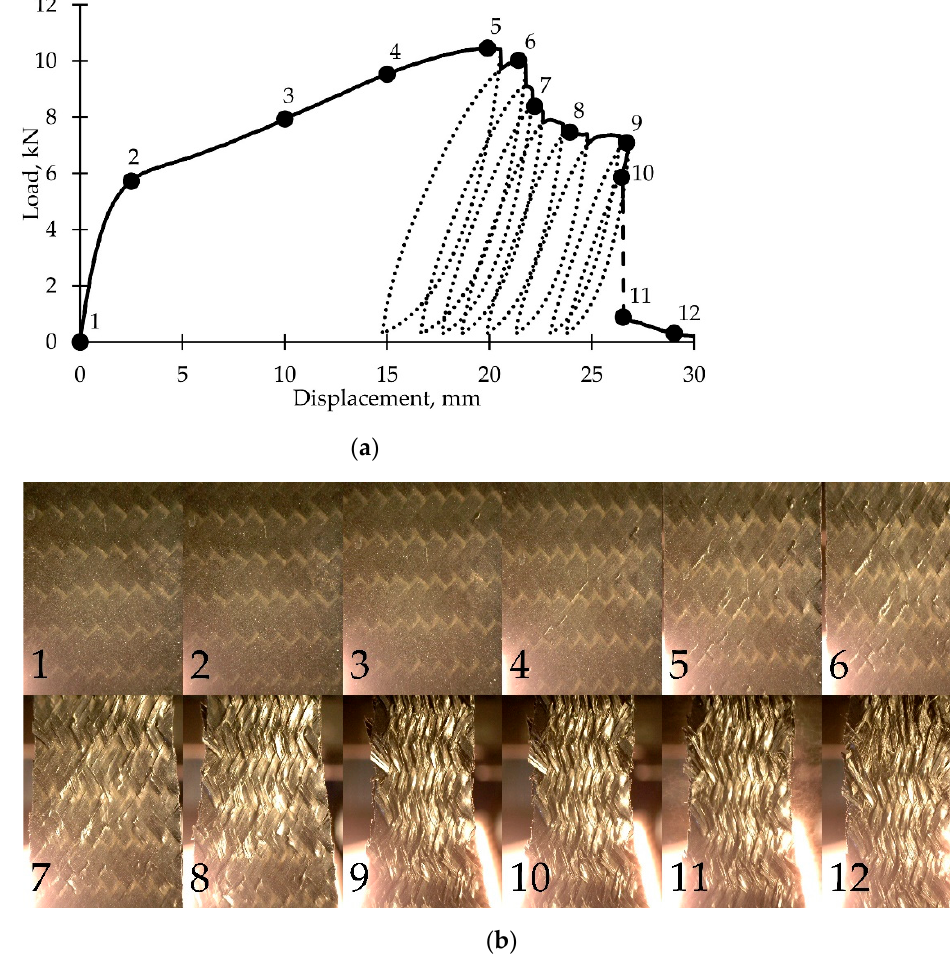
Figure 10. The surface defects development during the tension: ( a ) Loading diagram; ( b ) surface pictures corresponding to points 1–12 on the loading diagram.